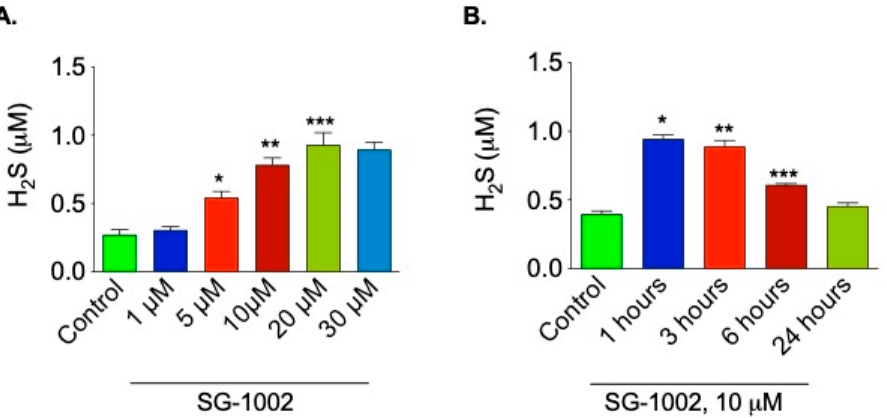
Figure 1. Time course and dose responses of SG-1002 on H 2 S production. HL-1 cardiac muscle cells were incubated either with different concentrations of SG-1002 for 1 h ( A ) or with 10 mM of SG-1002 for several time periods ( B ) in 1% serum containing media followed by the measurement of H 2 S levels in culture media. * , **, and ***. p < 0.05 versus (vs.) control (n = 4).